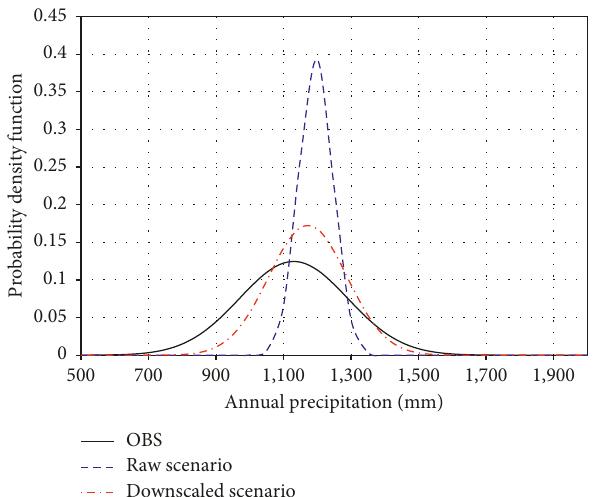
Figure 4: Observation and probability density functions before and after application of SDQDM (annual